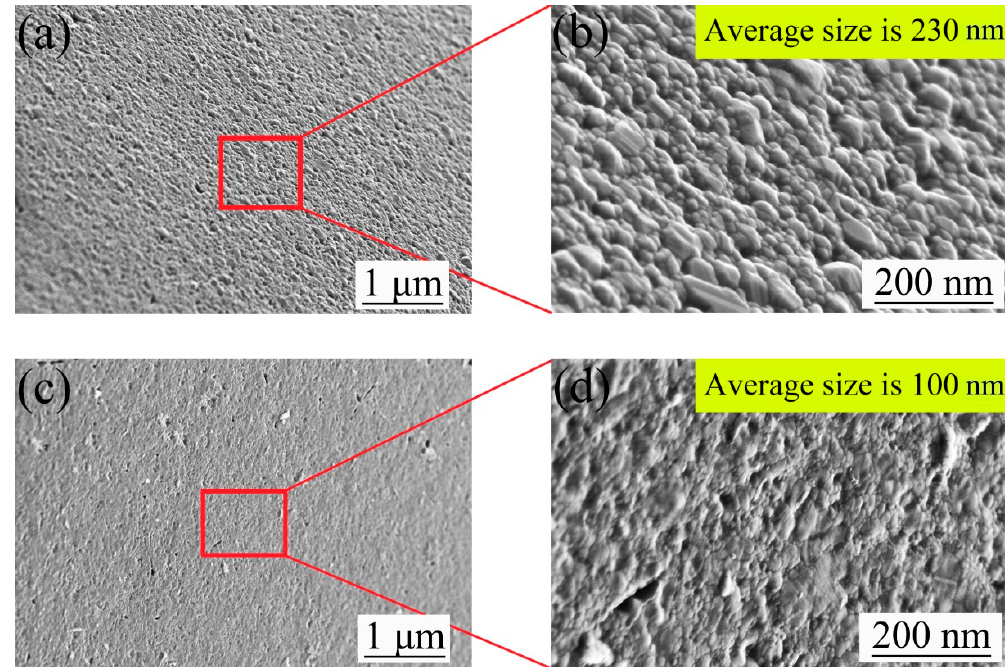
Figure 8. ( a , b ): The micromorphology of nickel mold after mold release under scheme 1; ( c , d ): The micromorphology of nickel mold after mold release under scheme 2.